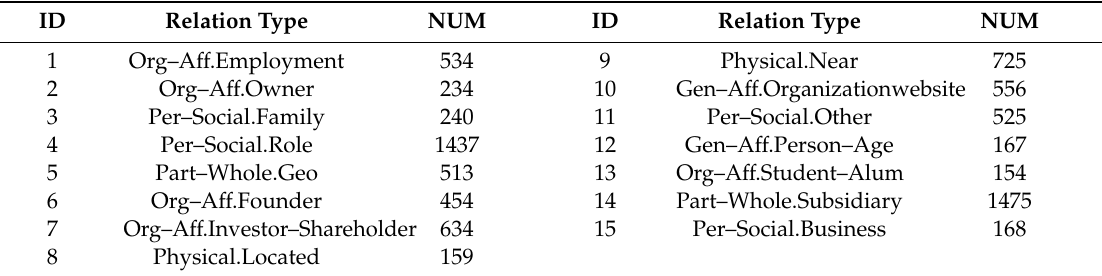
Table 11. Numbers of individual relation types observed in the initial corpus.